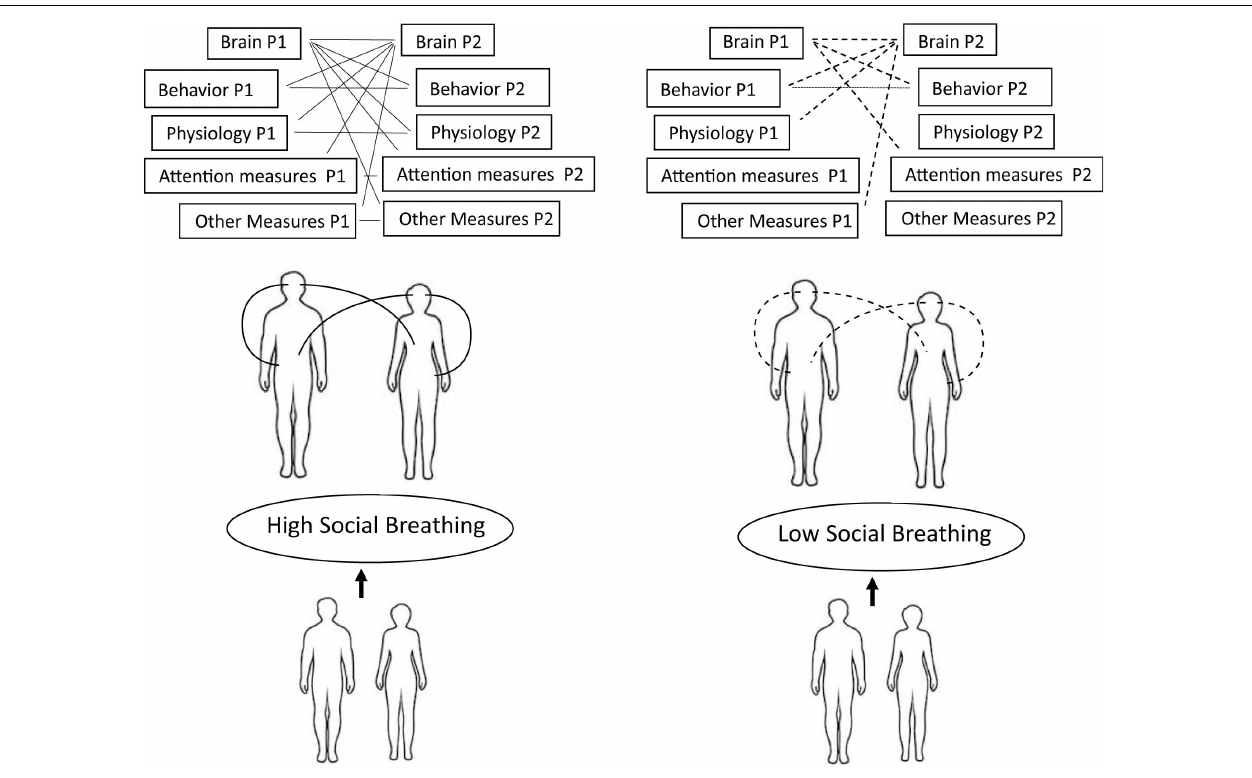
FIGURE 2 | A proposal for measuring the latent construct of Social Breathing. We suggest that Social Breathing can be measured during temporally contingent social interactions using repeated measures of the multi-person whole-brain-body system. Higher Social Breathing is indicated by a denser network of connections among the observed measures, which would support the emergence of more complex forms of interpersonal coordination. In contrast, lower Social Breathing would be indicated by fewer or weaker connections among the measured nodes in the network, as indicated by the reduced number of connections and the dotted rather than solid lines in the